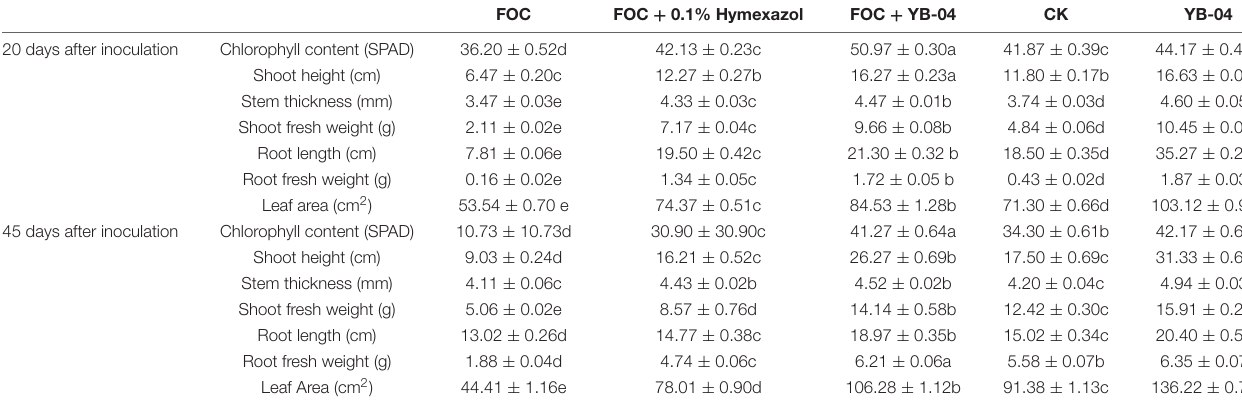
TABLE 2 | Effects of B. subtilis YB-04 on growth parameters of cucumber seedlings.